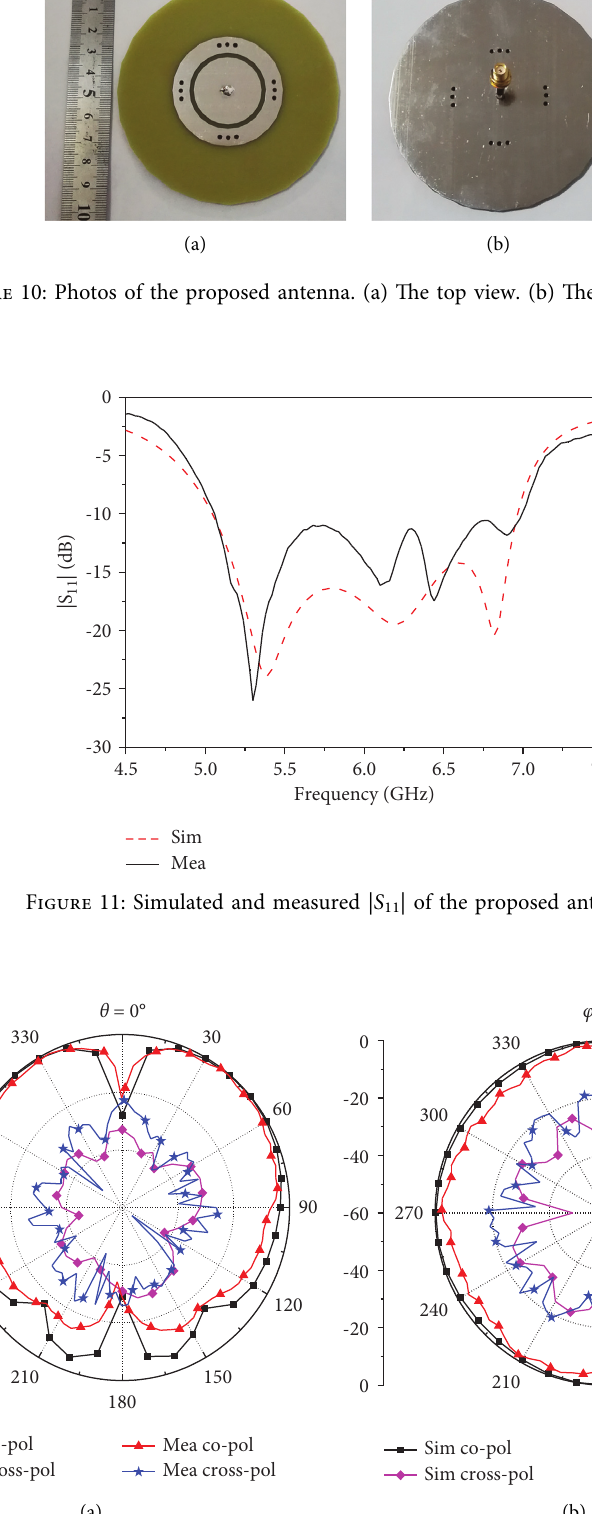
Figure 12: Simulated and measured radiation patterns at 5.4GHz. (a) φ � 0 ° ( x - z plane). (b) θ � 50 °